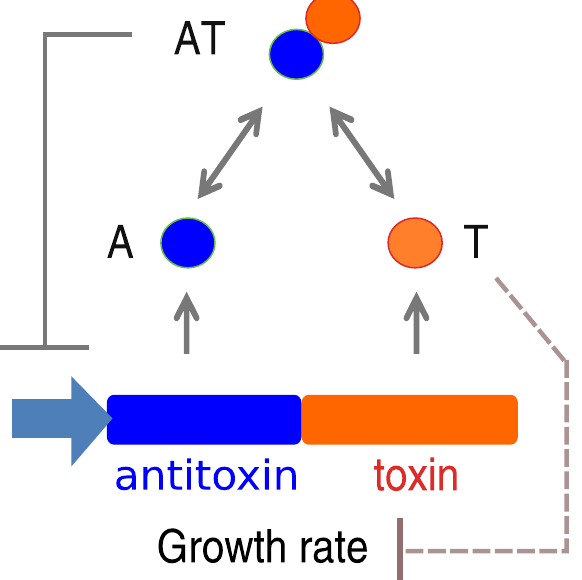
Figure 2. Schematic overview of the minimal model. Toxin T and antitoxin A are expressed by neighbouring genes. A TA complex molecule AT can be formed from one toxin and one antitoxin molecule. The AT molecule down-regulates A and T production. At the same time toxin molecules inhibit cell